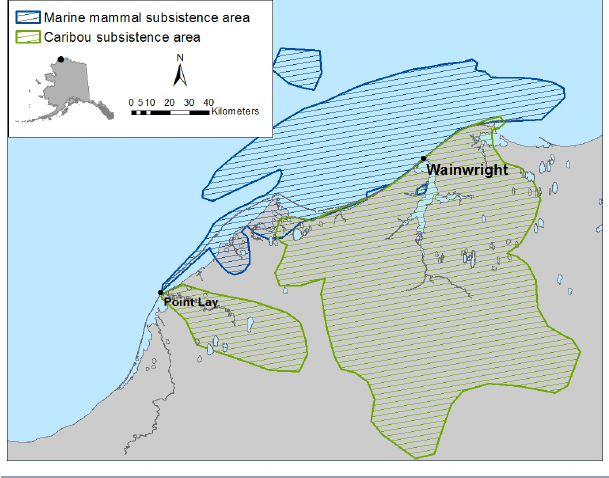
Fig. 2 . Map of Wainwright, Alaska displaying marine mammal and caribou subsistence use areas (Braund 2012, Wainwright Trilateral Committee 2014). N.B. The use area shown near the neighboring village of Point Lay is the area used by Wainwright hunters, not Point Lay’s own use